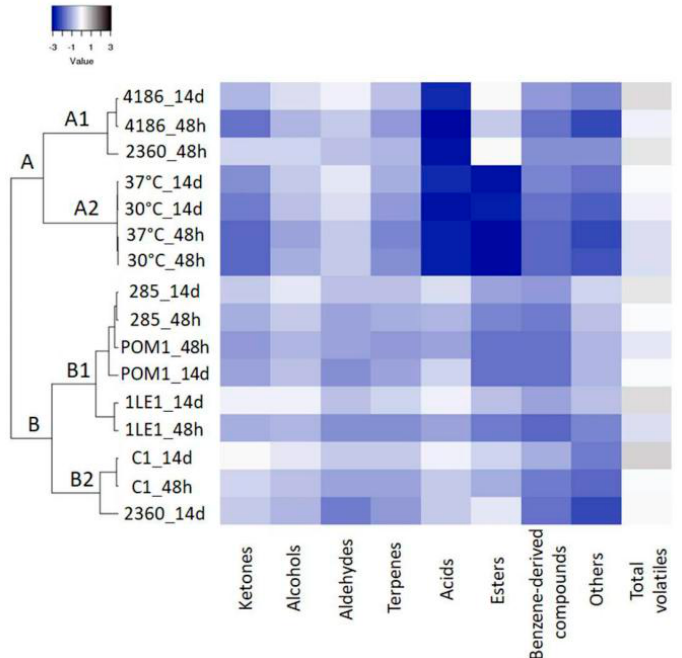
Figure 3. Volatile profile. Hierarchical clustering and heat map performed on sugars and organic acids detected in fermented cherry juice with L. plantarum (C1, 1LE1, POM1 and 285), L. rhamnosus (2360) and L. paracasei (4186) and in unfermented juice (30 ◦ C and 37 ◦ C) after 48 h and 14 days (storage). A scale ranging from a maximum of 3 (black) and a minimum of − 3 (blue) was used.